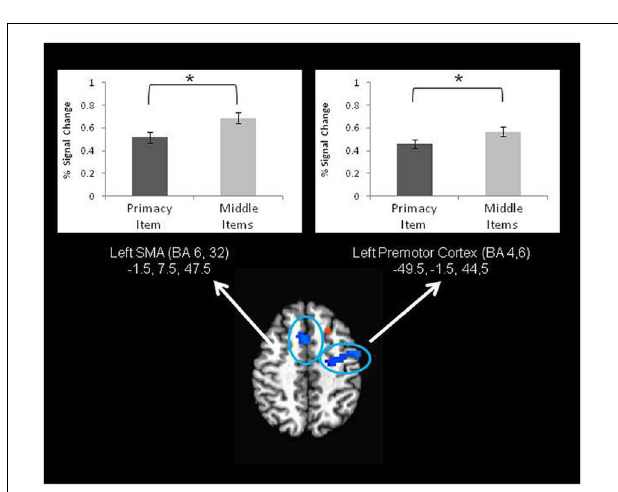
FIGURE 5 | Two frontal lobe regions exhibiting higher activation during middle item trials than primacy item trials during the retrieval period of a JOP task. This represents a neural correlate of the behavioral primacy effect in a JOP task. ∗ denotes significance at p < 0 . 05.